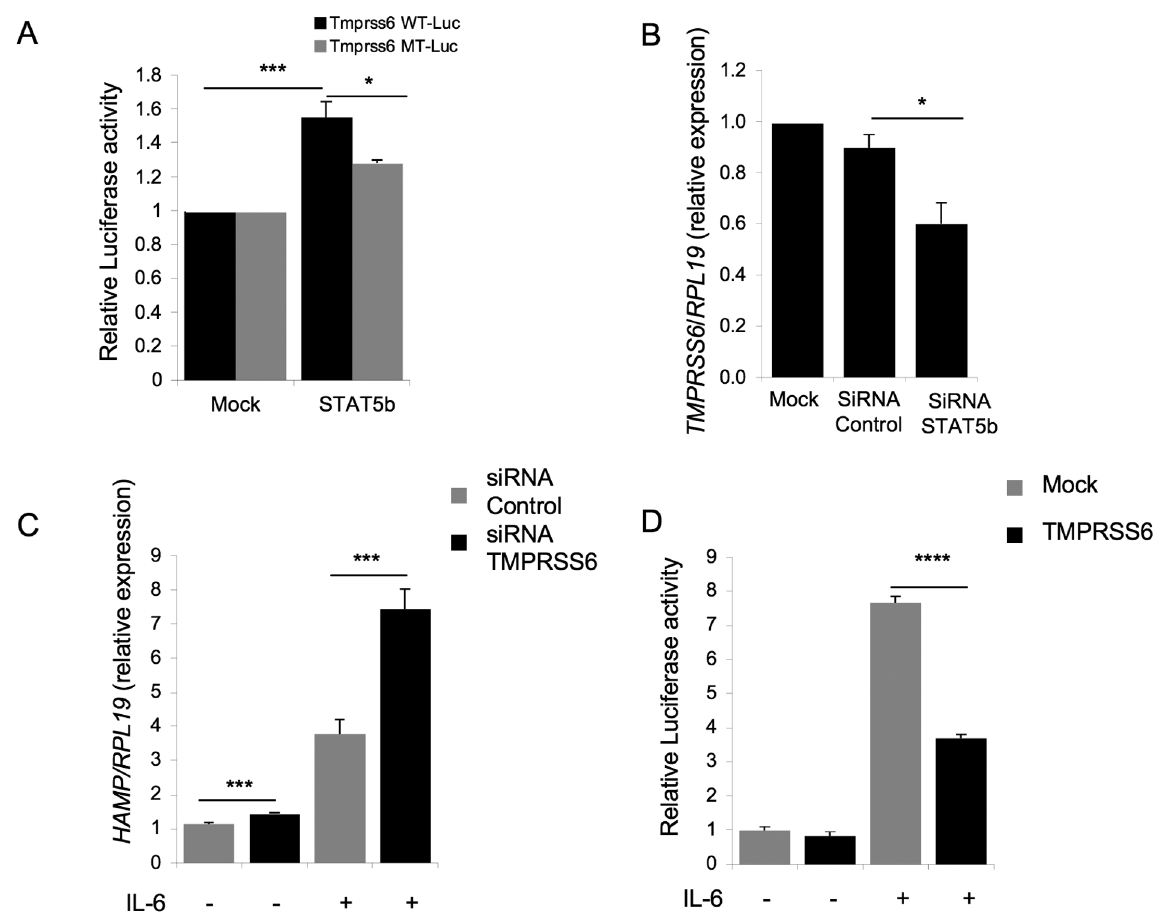
Figure 4. Stat5 regulates Tmprss6 expression and this participates to the regulation of hepcidin expression by IL-6 treatment. (A) Hepa 1–6 cells were transfected with mouse wild-type or mutant Tmprss6 promoter-luciferase construct, in presence of empty vector or Stat5b plasmid. After 48 hours, luciferase activity was determined. The assay was performed in duplicate for a total of 6 independent experiments. For each experiment, raw data were normalized to the value of luciferase activity in cells transfected with the empty vector. Values shown are mean of normalized luciferase activities + / 2 SEM. Mean in treated groups was compared to 1 by one sample student t tests. (B) Hep3B cells were transfected with siRNA control or siRNA Stat5b and analyzed for TMPRSS6 relative to RPLl19 mRNA expression. For each experiment, raw data were normalized to the expression value in mock-treated cells. Values shown are means of normalized expression values obtained in 3 independent experiments + / 2 SEM. Means in siRNA control and siRNA STAT5b groups were compared by student t tests. (C) Hep3B cells were transfected with siRNA control or siRNA TMPRSS6 and treated without or with 20 ng/mL of IL-6, followed by analysis of HAMP relative to RPL19 mRNA expression. The mean 4 independent experiments is presented. Values shown are means of expression values divided by a calibrator quantity (the mean value of expression for the cells transfected with siRNA control non-treated with IL-6) + / 2 SEM. Means in non-treated and IL-6 treated groups were compared by student t tests. (D) Hep3B cells were transfected with human HAMP promoter-luciferase construct in combination with either empty vector or human TMPRSS6 plasmid. Thirty-two hours after transfection, cells were treated without or with 20 ng/ml of IL-6. After 16 hours of IL-6 treatment, luciferase activity was determined. The assay was performed in duplicate for a total of 6 independent experiments. Values shown are means of luciferase activity divided by a calibrator quantity (the mean value of luminescence for the mock non-treated with IL-6) + / 2 SEM. Means in non-treated and IL-6 treated groups were compared by student t tests. P values p , 0.05 were considered statistically significant. Significances are: *p ,